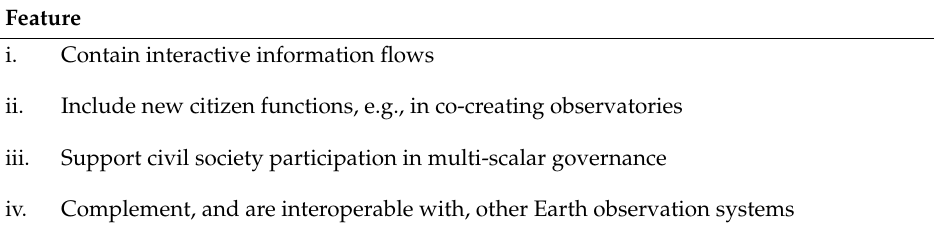
Table 3. A list of distinctive features of effective citizen observatories that refines features proposed earlier [33].